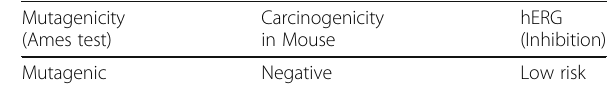
Table 8 Toxicological properties of betulinic